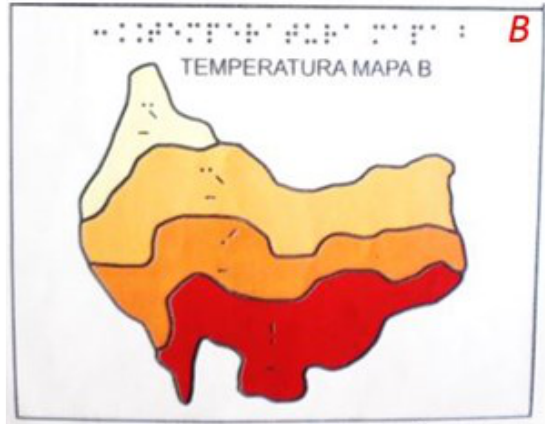
Figure 12. Map B, theme: Temperature, printed on special paper with sequential colors along with the tactile language of the See Color